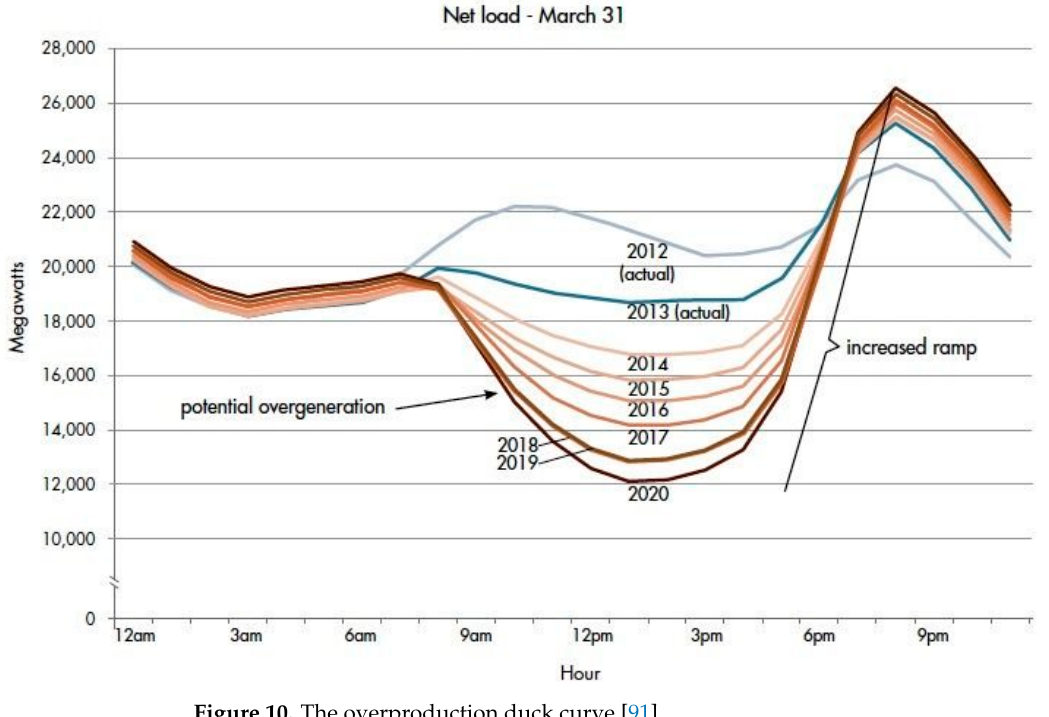
Figure 10. The overproduction duck curve [91].